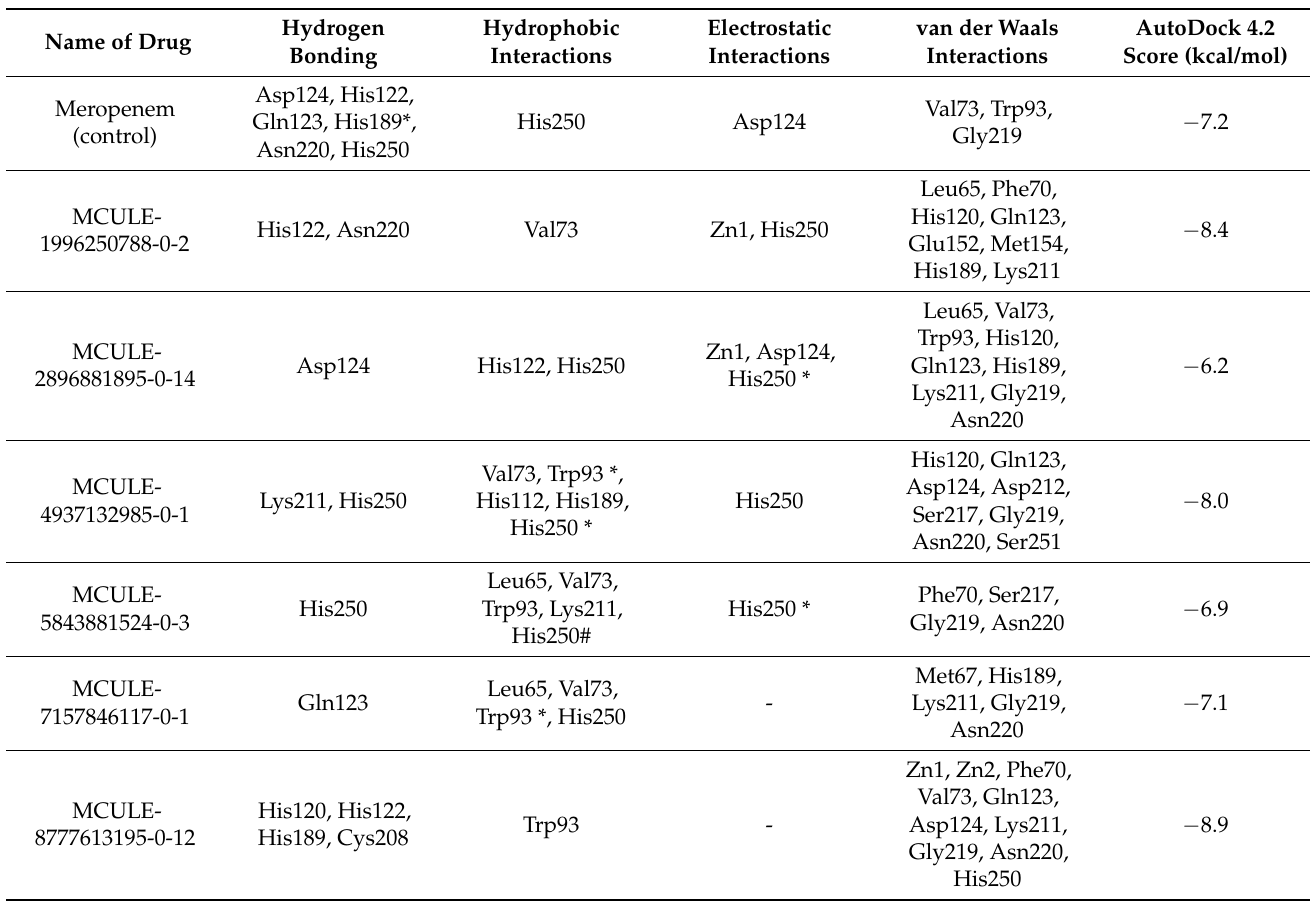
Figure S2B). The docking energy of the interaction between MCULE-1996250788-0-2 and NDM-1 was estimated as − 8.4 kcal mol − 1 . Table 2. Molecular docking parameters of shortlisted ligands and NDM-1